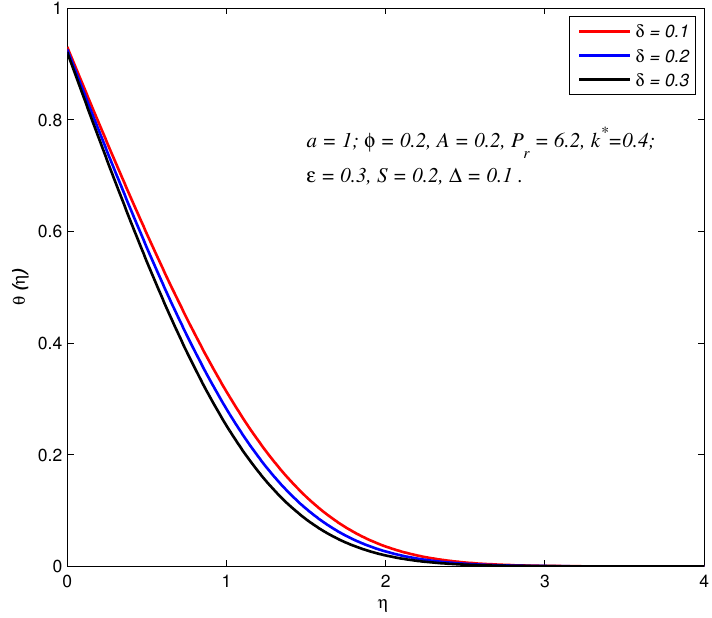
Figure 12. Temperature θ ( η ) profiles for different values of velocity slip parameter δ